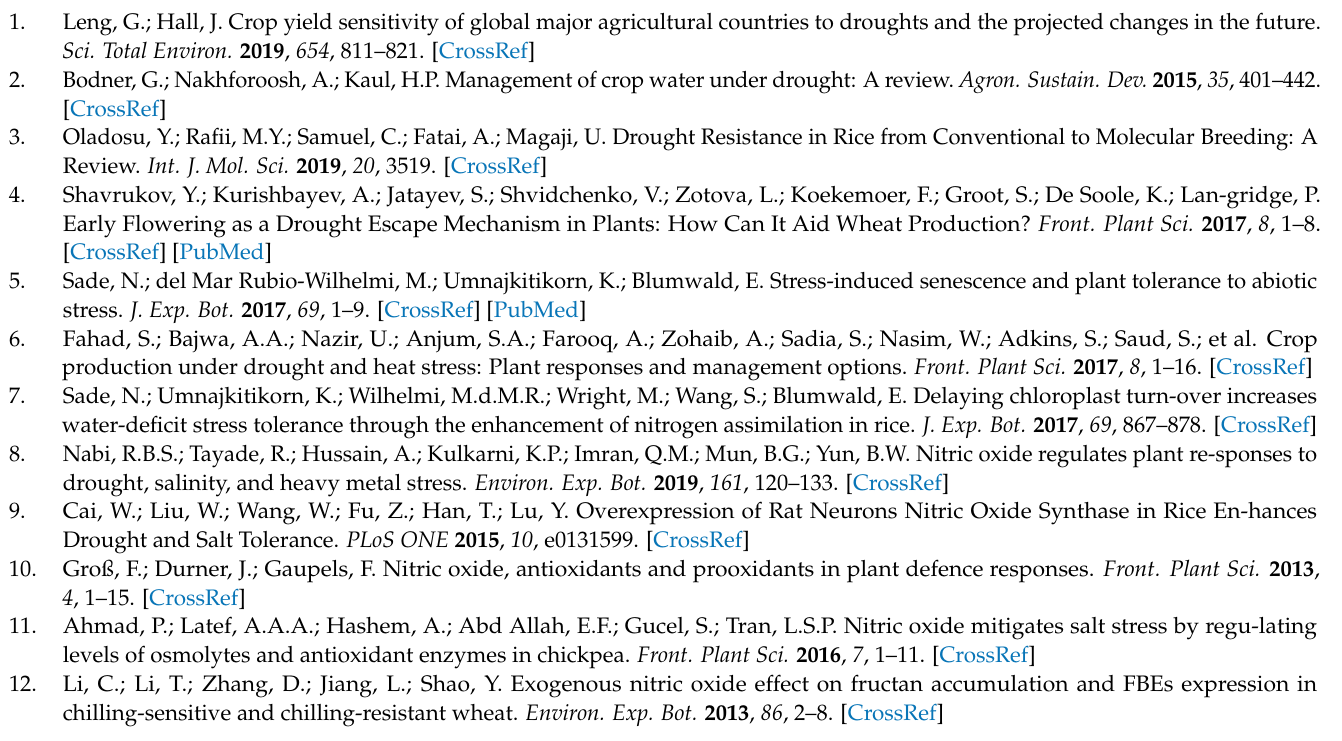
file 2: Figure S1: Examples of the picture calibrated for staining area evaluation. Figure S2: The ROS staining area of tissue segments of rice plants after 3–day growth in the different NO-associated treatments; Procedure for staining area quantification by image